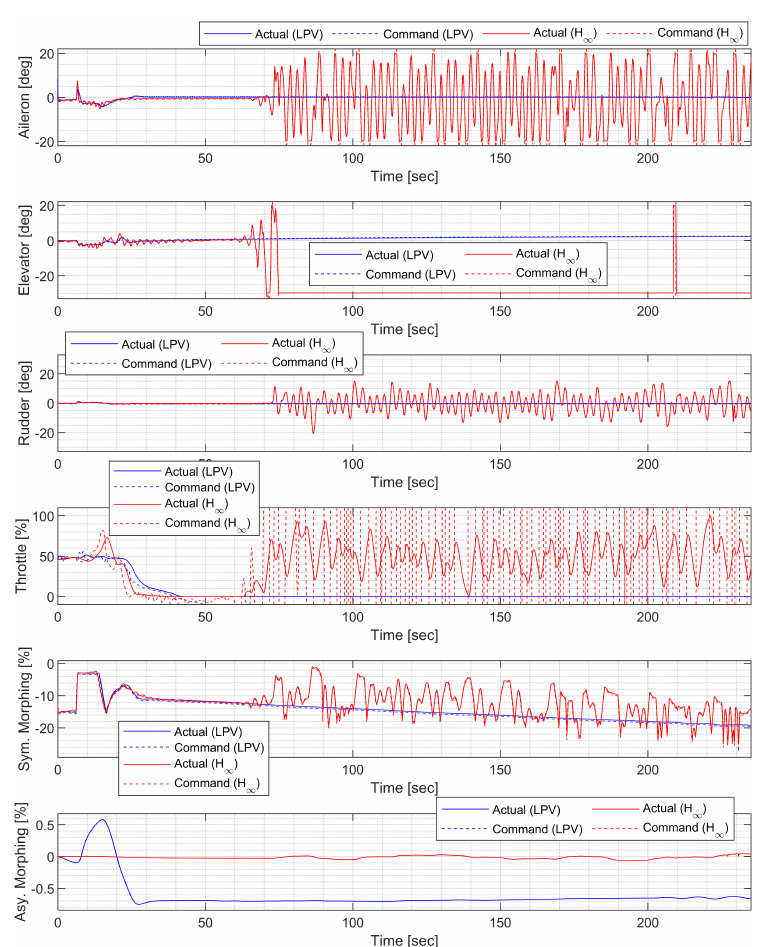
Figure 31. Input history of the spiral